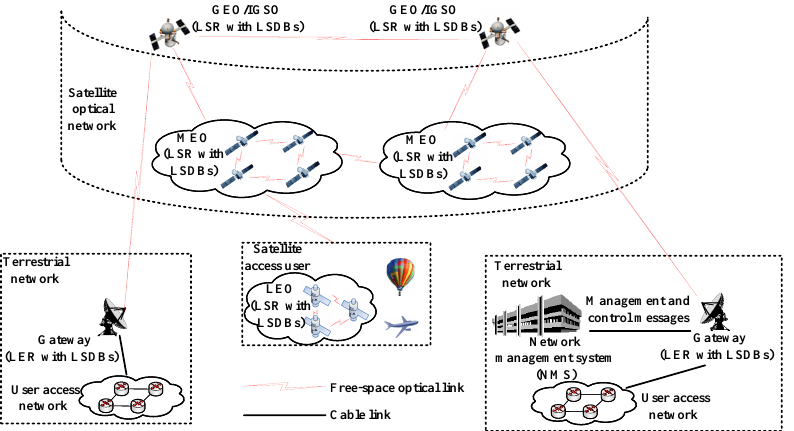
Figure 1. The typical application scenario of